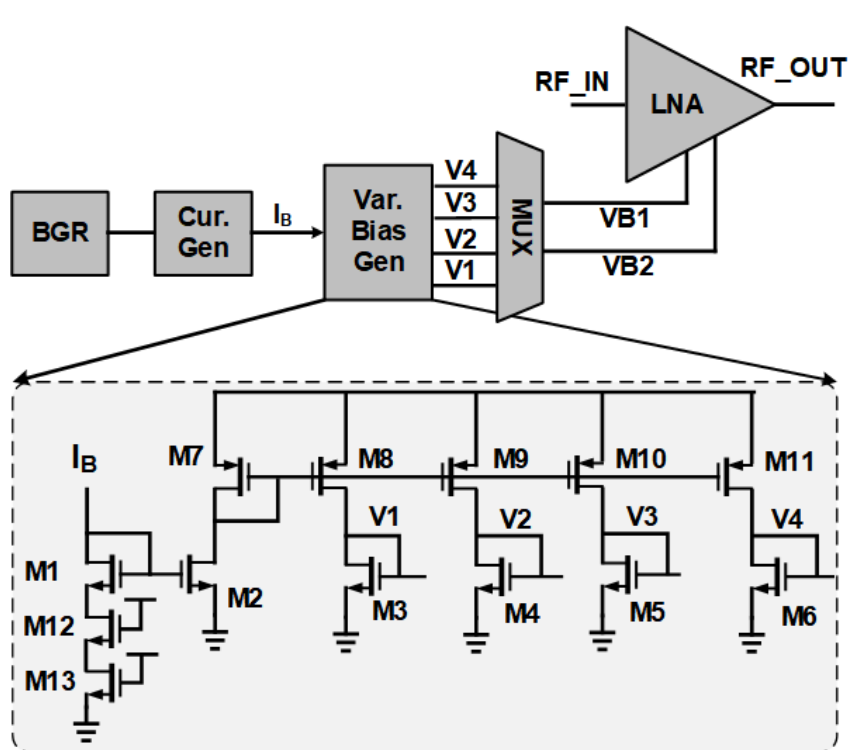
Figure 3. A digitally controllable bias voltage